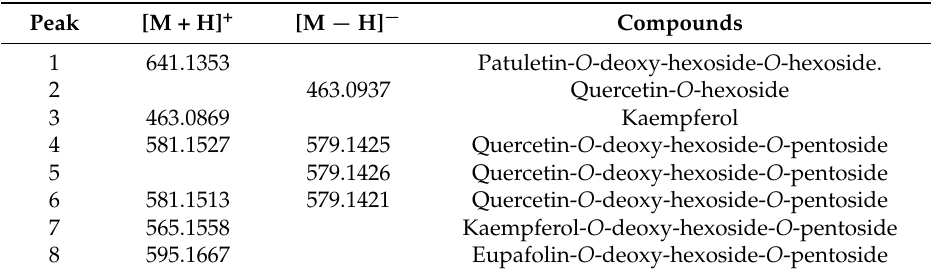
Table 2. Compounds identified by UHPLC-MS in Kalanchoe pinnata leaf